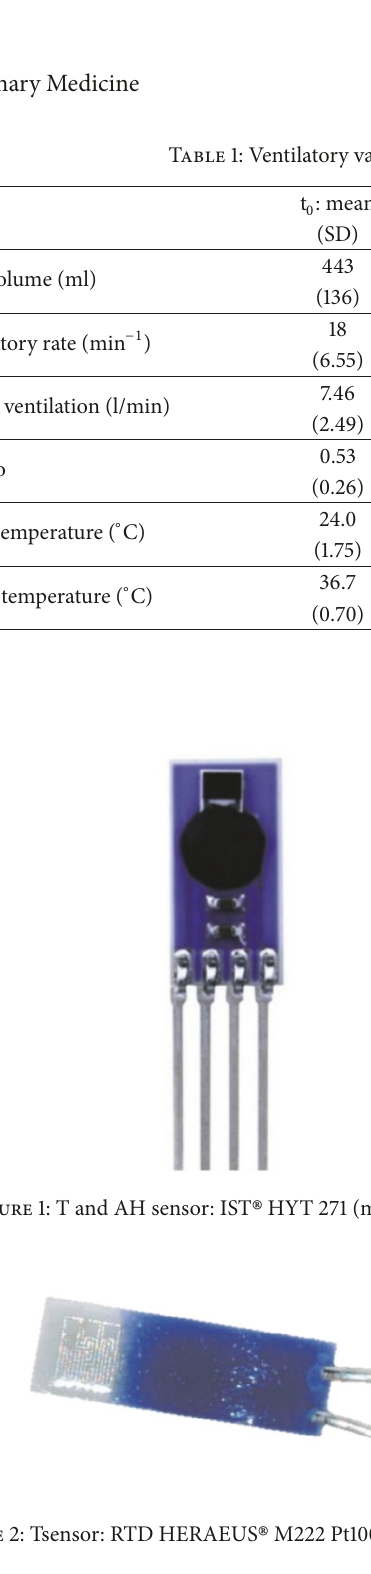
from 5% to 14% depending on respiratory frequency rate and I:E ratio, so the error trend was linear with the increase of the respiratory frequency rate and was inversely proportional to the I:E ratio